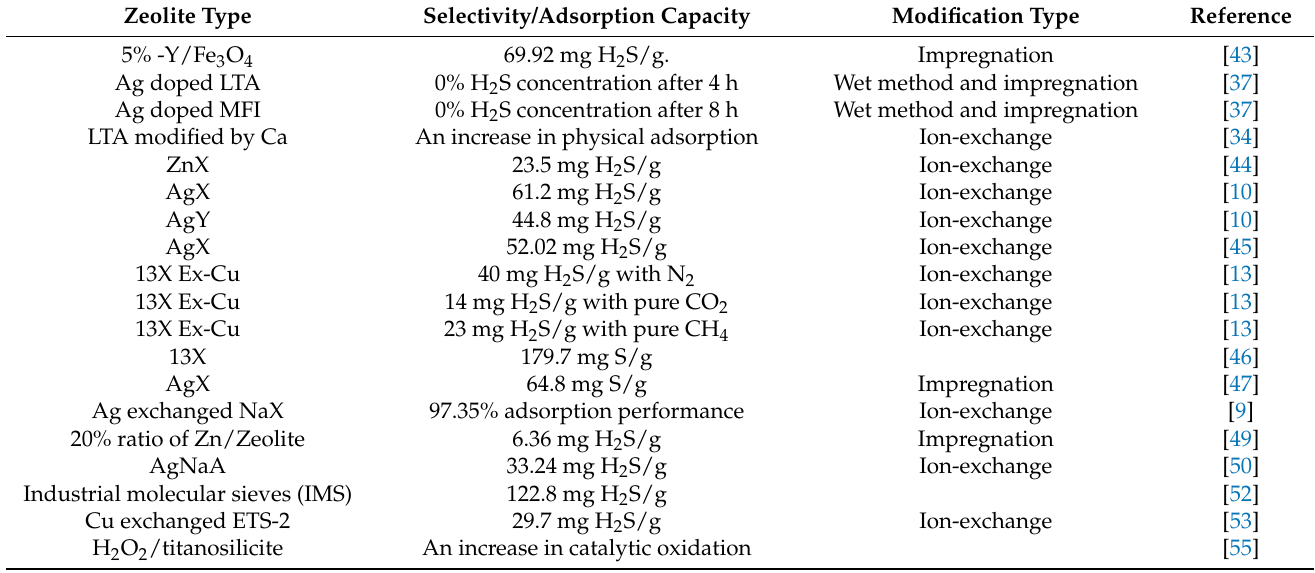
Table 5. Studies based on modification of synthetic